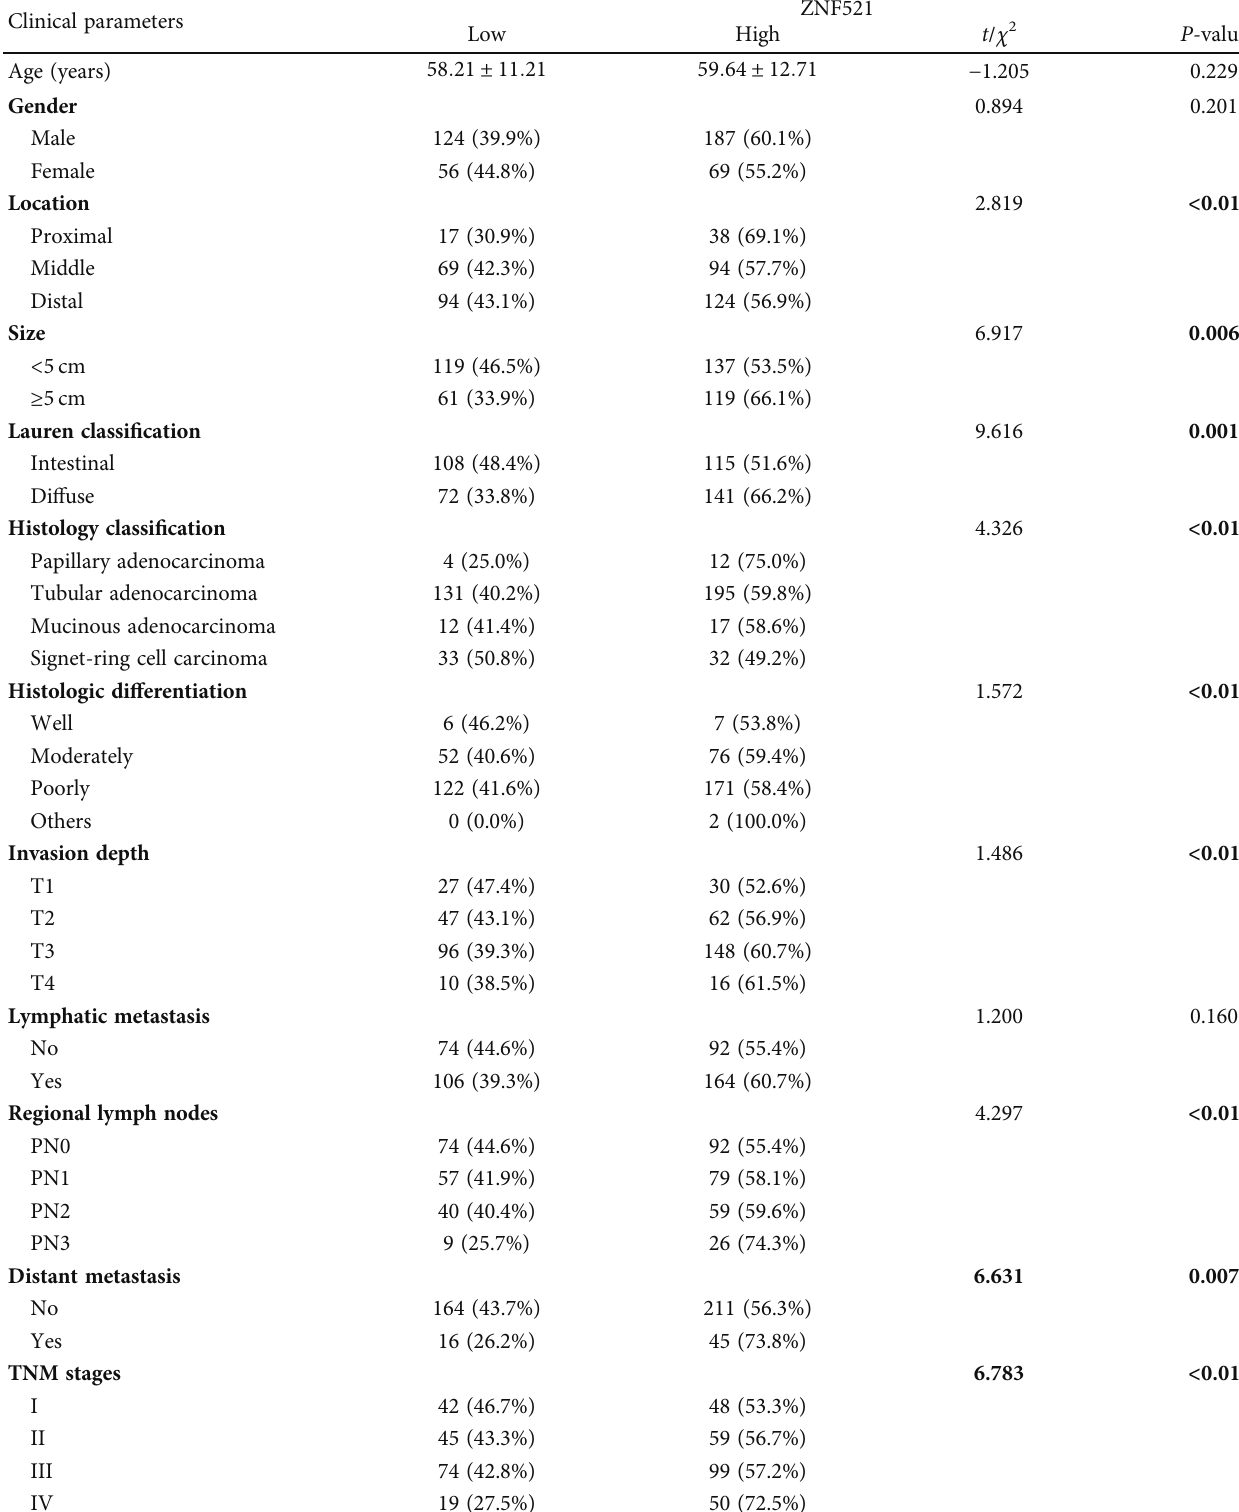
Table 1: Relationship of ZNF521 expression with pathological characteristics of gastric